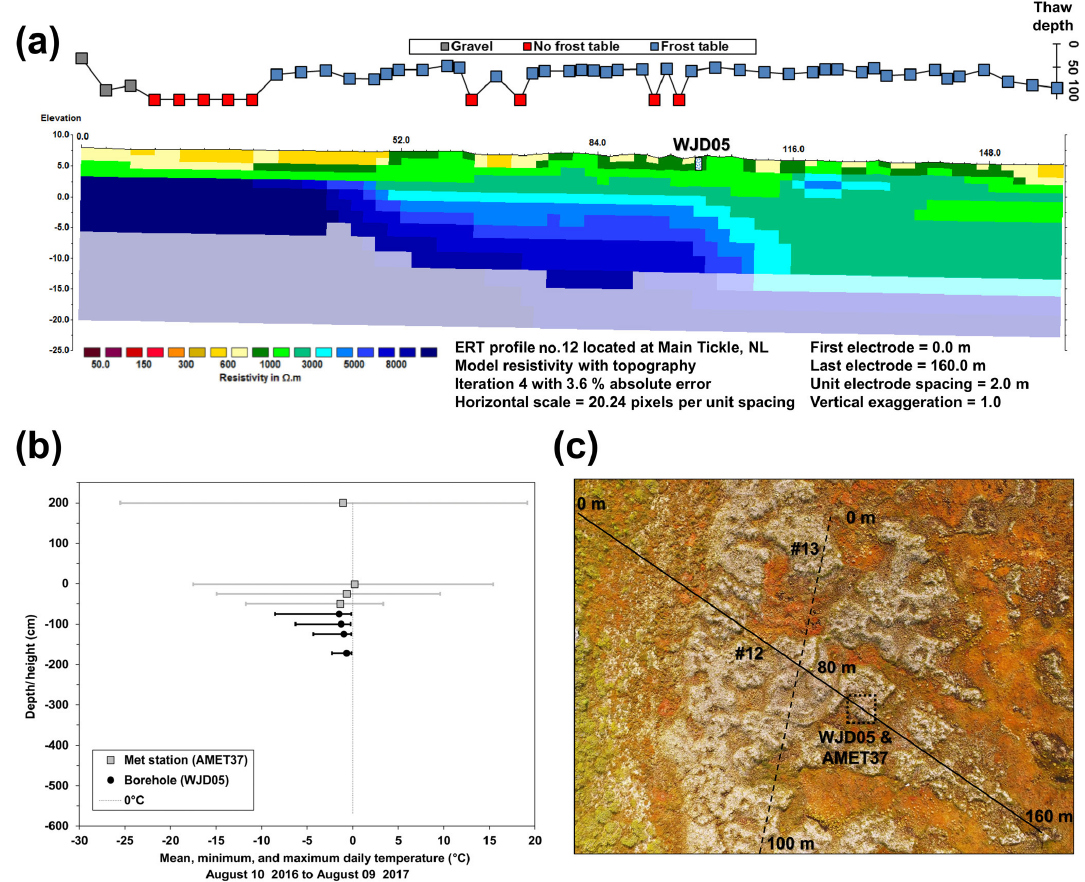
Figure 8. Peatland permafrost at Main Tickle. (a) Frost tables and modelled resistivities on ERT profile 12. Depths with permafrost in borehole WJD05 are denoted by hatching. Note that the colour scale differs from that in Figs. 3–7 to differentiate among zones of high resistivity. Consequently, some green zones on this modified scale are inferred to be frozen. (b) Air and ground temperature envelopes (2016–2017). (c) UAV vertical image of the site. Black line delimits the approximate location of the ERT survey line and text shows the start and end